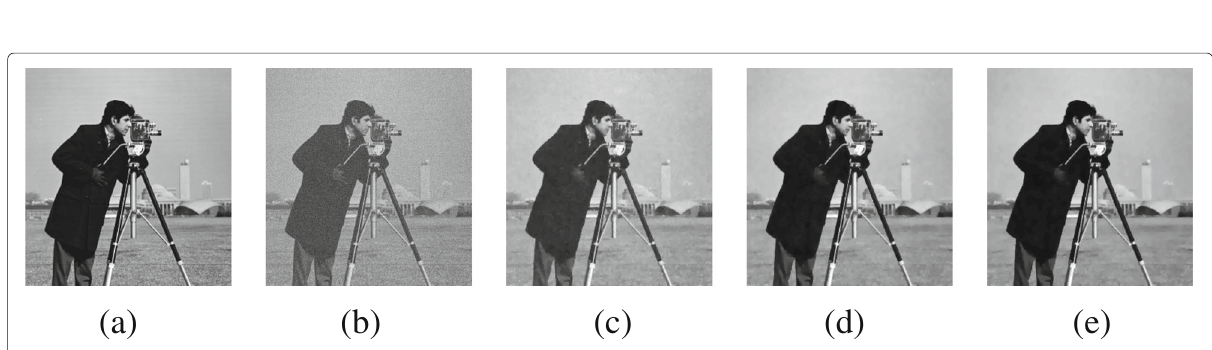
Fig. 8 Experimental results on “Cameraman” image; a original image; b noisy image with σ = 20; c restored image by method M1; d restored image by method M2; e restored image by method